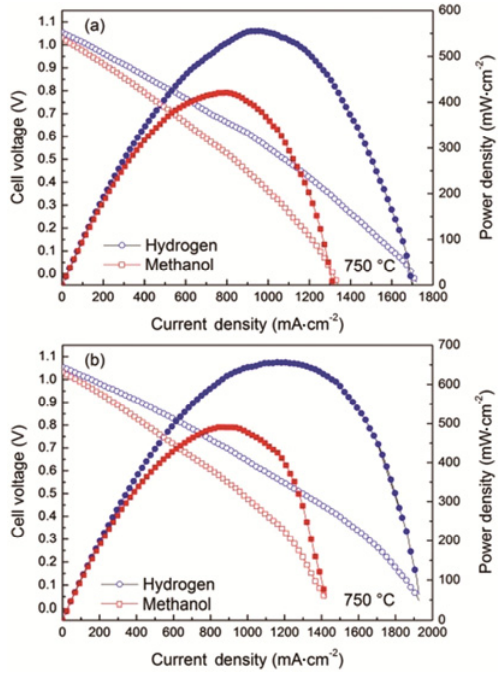
Fig. 5 Current voltage curves of single cells in hydrogen and methanol: (a) anode-supported single cell with a thin catalyst layer (Cell A) and (b) anode-supported single cell with an independent catalyst layer (Cell